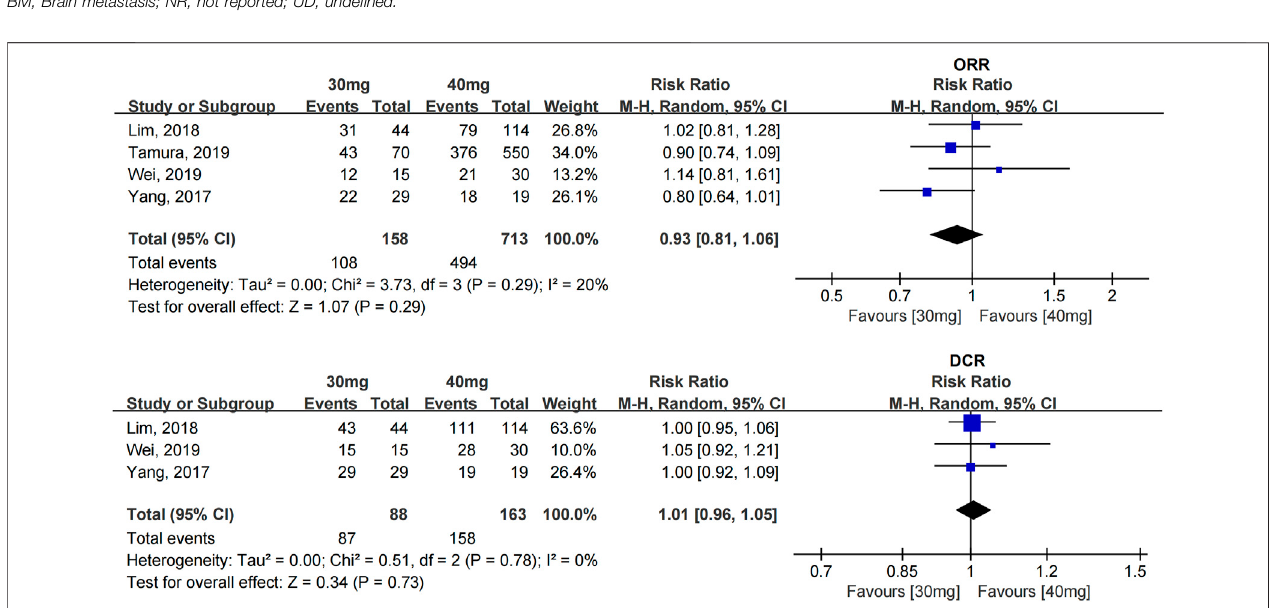
FIGURE 2 | Forest plot of the ORR and DCR in the meta-analysis of patients treated with 30 and 40 mg afatinib.